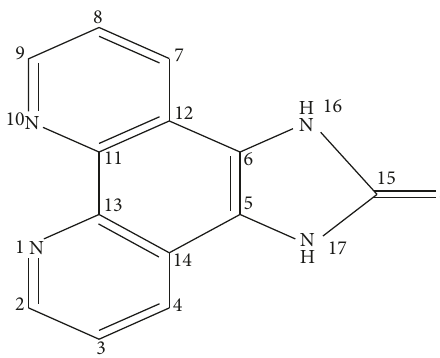
Figure 1: The structure of the synthesized ligand